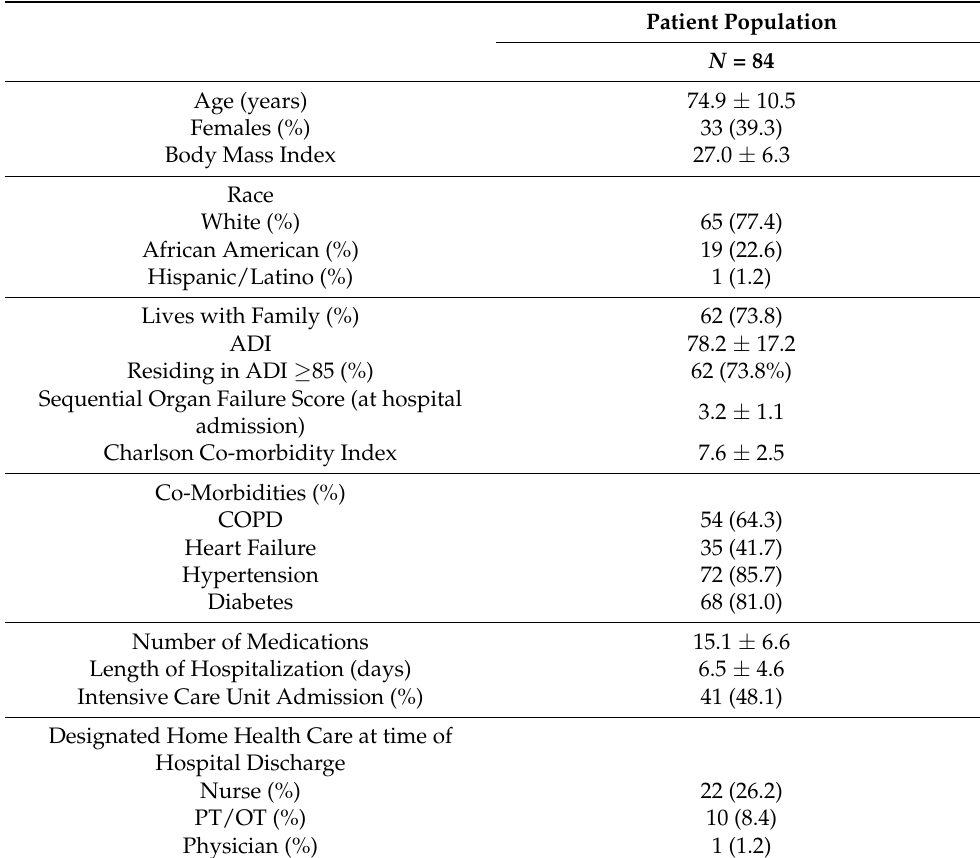
Table 1. Characteristics of the